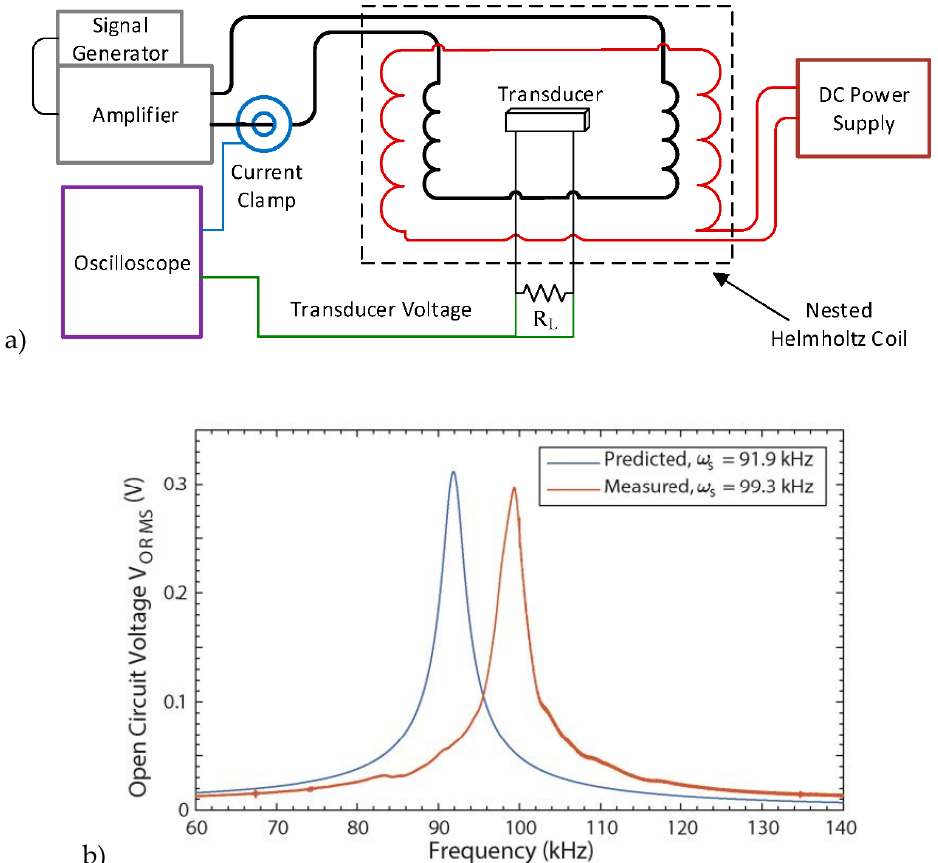
Figure 17. ( a ) The ME transducer experimental test setup diagram. ( b ) Metglas-PVDF open circuit voltage vs. frequency. Reproduced with permission from [107] .